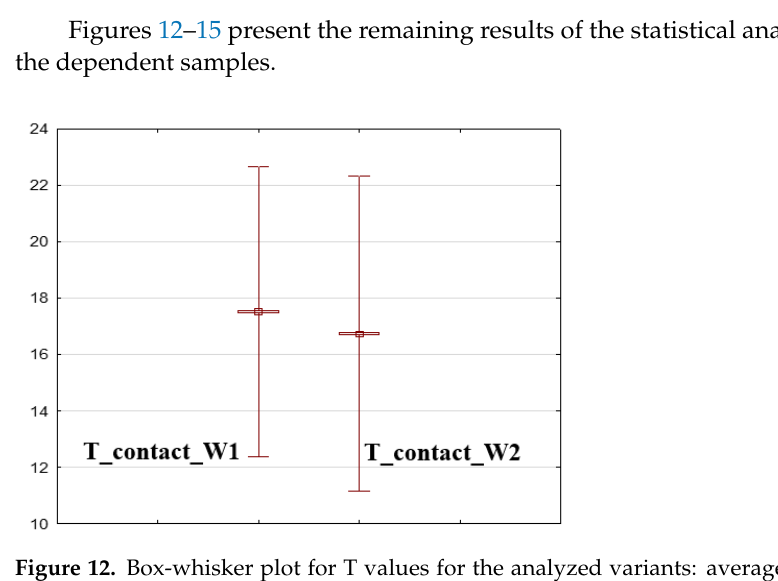
Figure 12. Box-whisker plot for T values for the analyzed variants: average, standard error, and standard deviation.